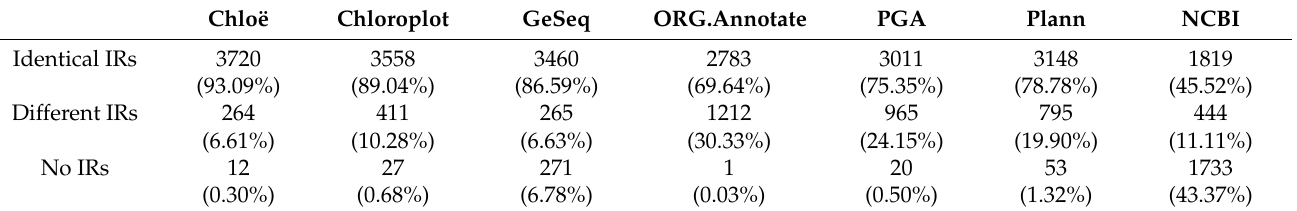
Table 3. Numbers of complete chloroplast sequences classified by type of IR regions identified (identical IRs, different IRs, no IRs) using six annotation tools (and those annotated in NCBI).